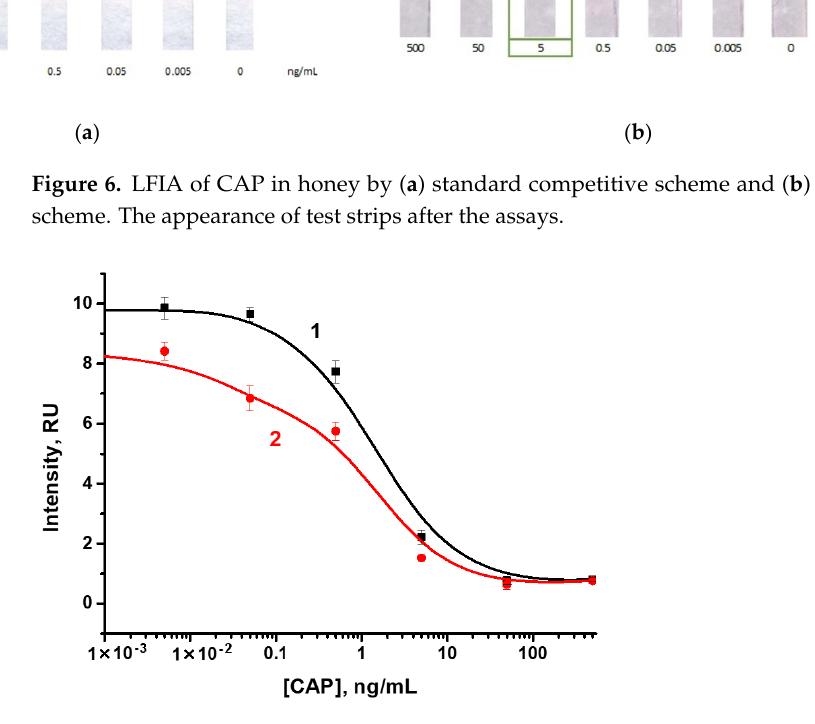
Figure 7. Color intensity in the analytical zones of test strips (from Figure 6) for the determination of CAP: (1) in the standard scheme of competitive LFIA; (2) in the proposed scheme of double competitive LFIA.